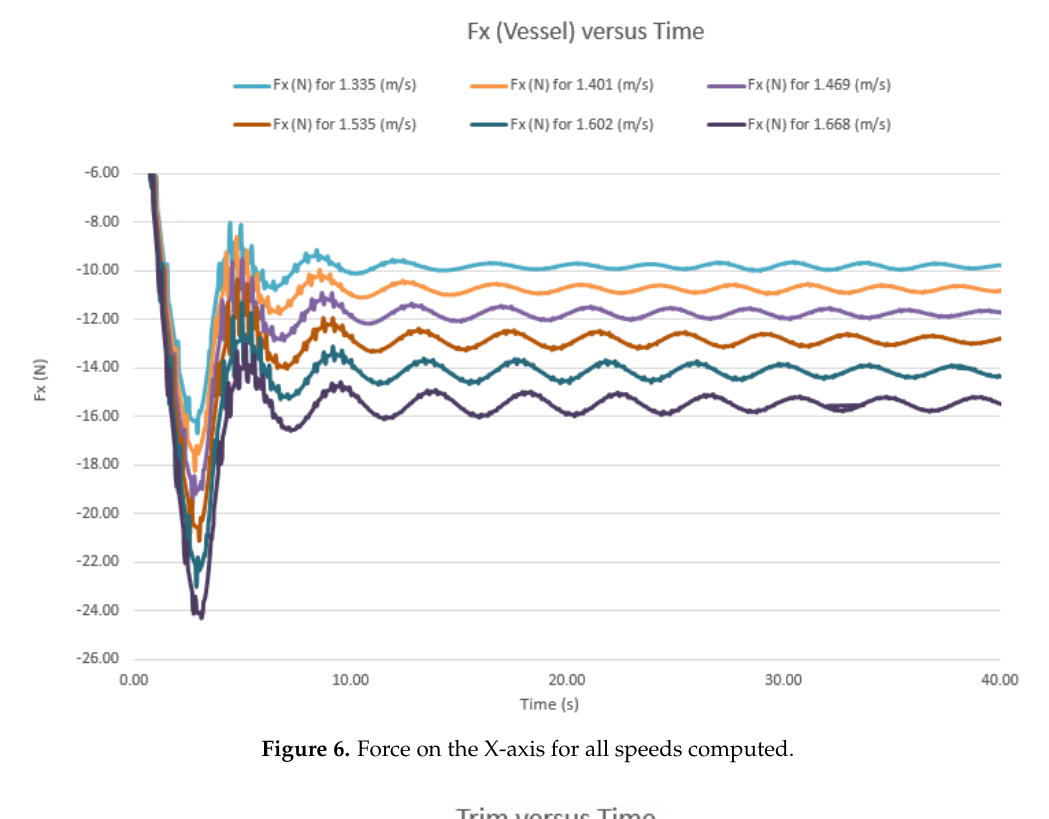
Figure 6. Force on the X-axis for all speeds computed.